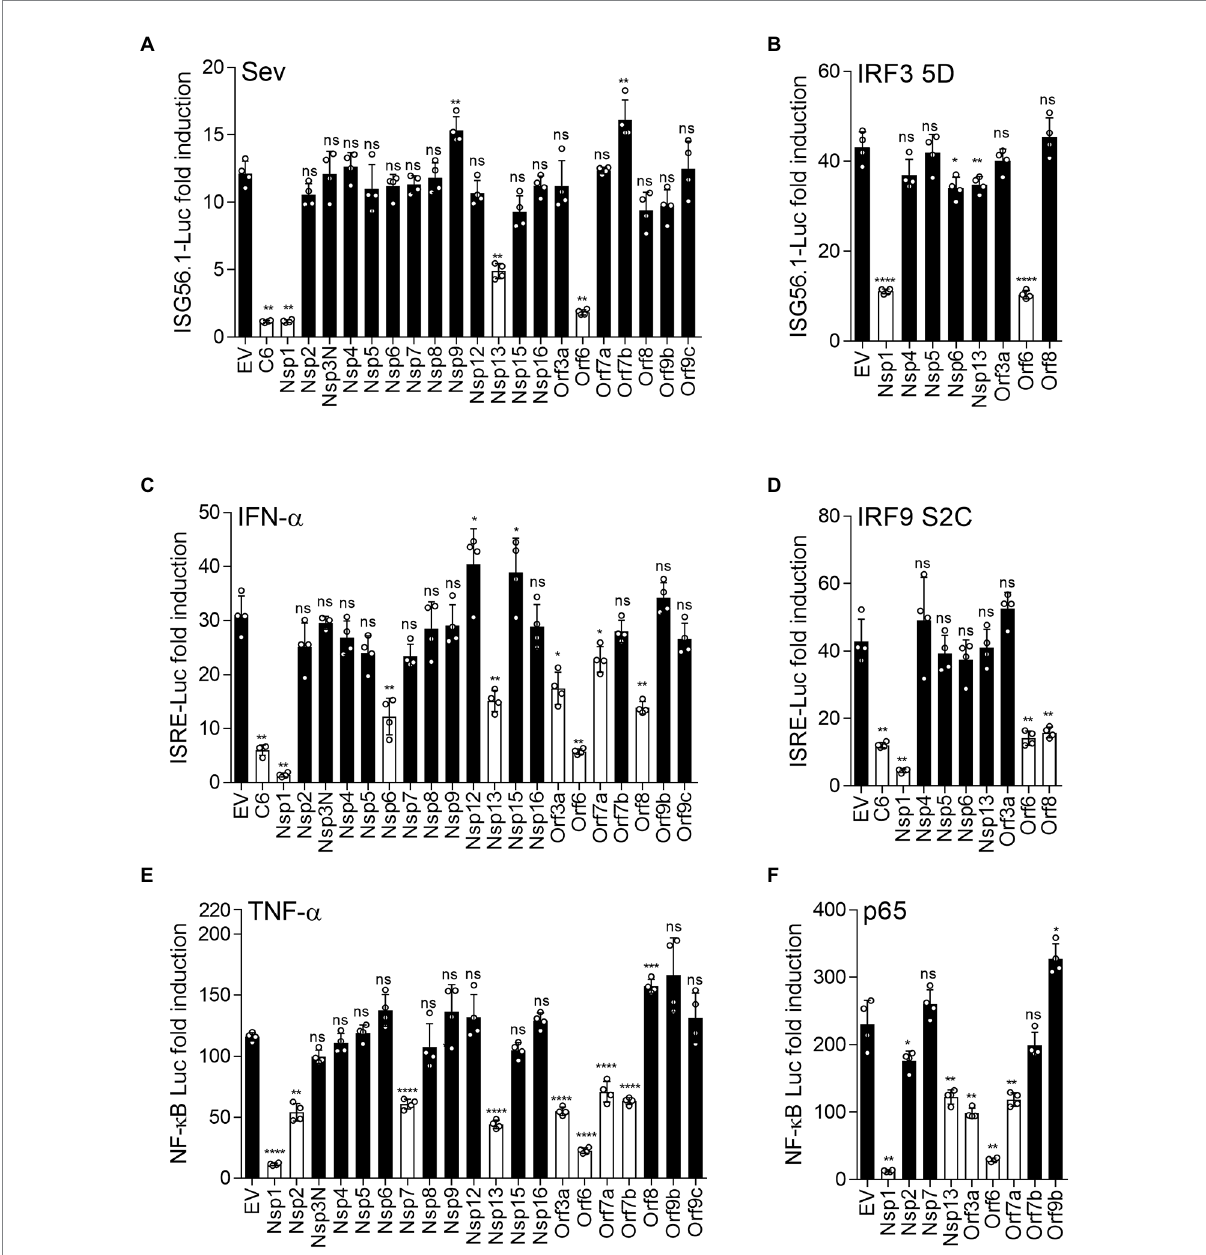
FIGURE 1 SARS-CoV-2 proteins inhibit innate immune pathway activation. HEK293 T cells were transfected with reporter plasmids ISG56.1-firefly luciferase (Fluc) (A,B) , ISRE-Fluc (C,D) , or NF- κ B-Fluc (E,F) , TK- Renilla , and plasmids expressing the indicated SARS-CoV-2 proteins fused to a FLAG epitope at the C terminus. After 18 h, transfected cells were stimulated by infection with 40 HAU/ml SeV (A) , 1,000 unit/ml IFN- α (C) , or 40 ng/ml TNF- α (E) . Cells in (B) , (D) , or (F) were transfected simultaneously with reporter plasmids and plasmids expressing IRF3-5D, IRF9-S2C or p65 to activate the IRF3 pathway, IRF9/STAT2-mediated ISG expression, or the NF- κ B pathway, respectively. After stimulation (overnight infection with SeV, or 6 h with IFN- α or TNF- α ), cell lysates were harvested, and firefly luciferase activity was measured and normalized to Renilla luciferase control. The fold induction of firefly luciferase is shown relative to unstimulated controls. Data shown are from 4 technical replicates and are representative of three independent experiments. Error bars represent standard deviation. The p -values were calculated using the unpaired Student’s t-test relative to empty vector. (* p < 0.05, ** p < 0.01, *** p < 0.001, **** p <